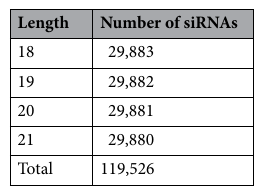
Table 1. Number of siRNAs of each